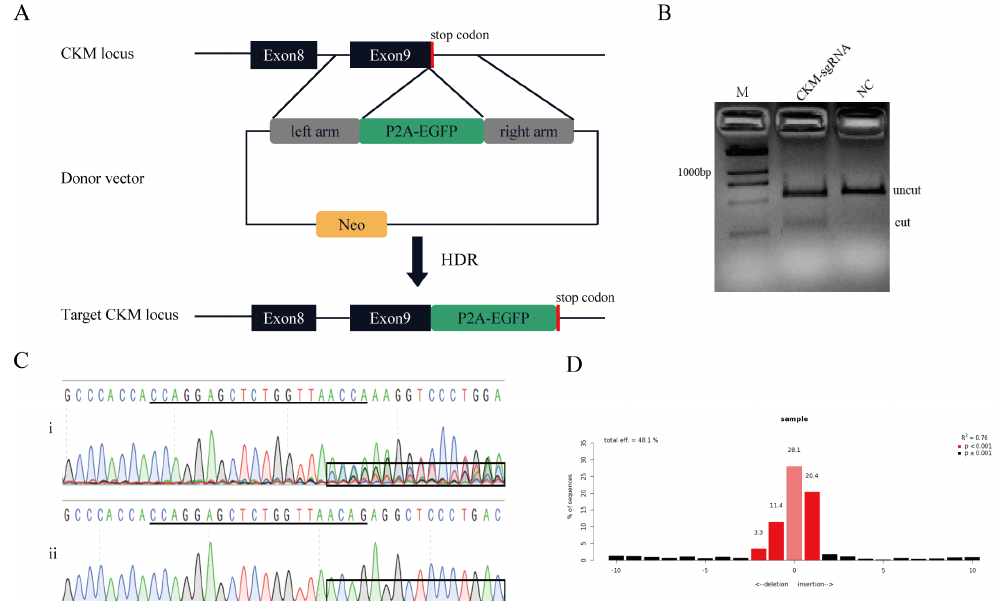
Figure 2. Schematic diagram of CKM locus gene targeting. ( A ) Exons of CKM are shown as black boxes, and the stop codon is shown as a red box. The black triangle box between exon 9 and the stop codon represent the sgRNA target site. The targeting donor was created according to the cleavage location of Cas9 and carried 800 bp regions of homology to the CKM sequence astride the cleavage site. The yellow box represents the resistance gene. ( B ) Identification of the activity of CKM-sgRNA by T7EN1 cleavage assay. NC, Negative Control; M, Marker, DL2000. ( C ) Sequence analysis showing that the presence of multiple peaks after the targeted site in the sequencing curves clearly distinguishes. ( i ) mutants, ( ii ) wild type. SgRNA sequence is underlined in black. ( D ) TIDE analysis of indel rate of the